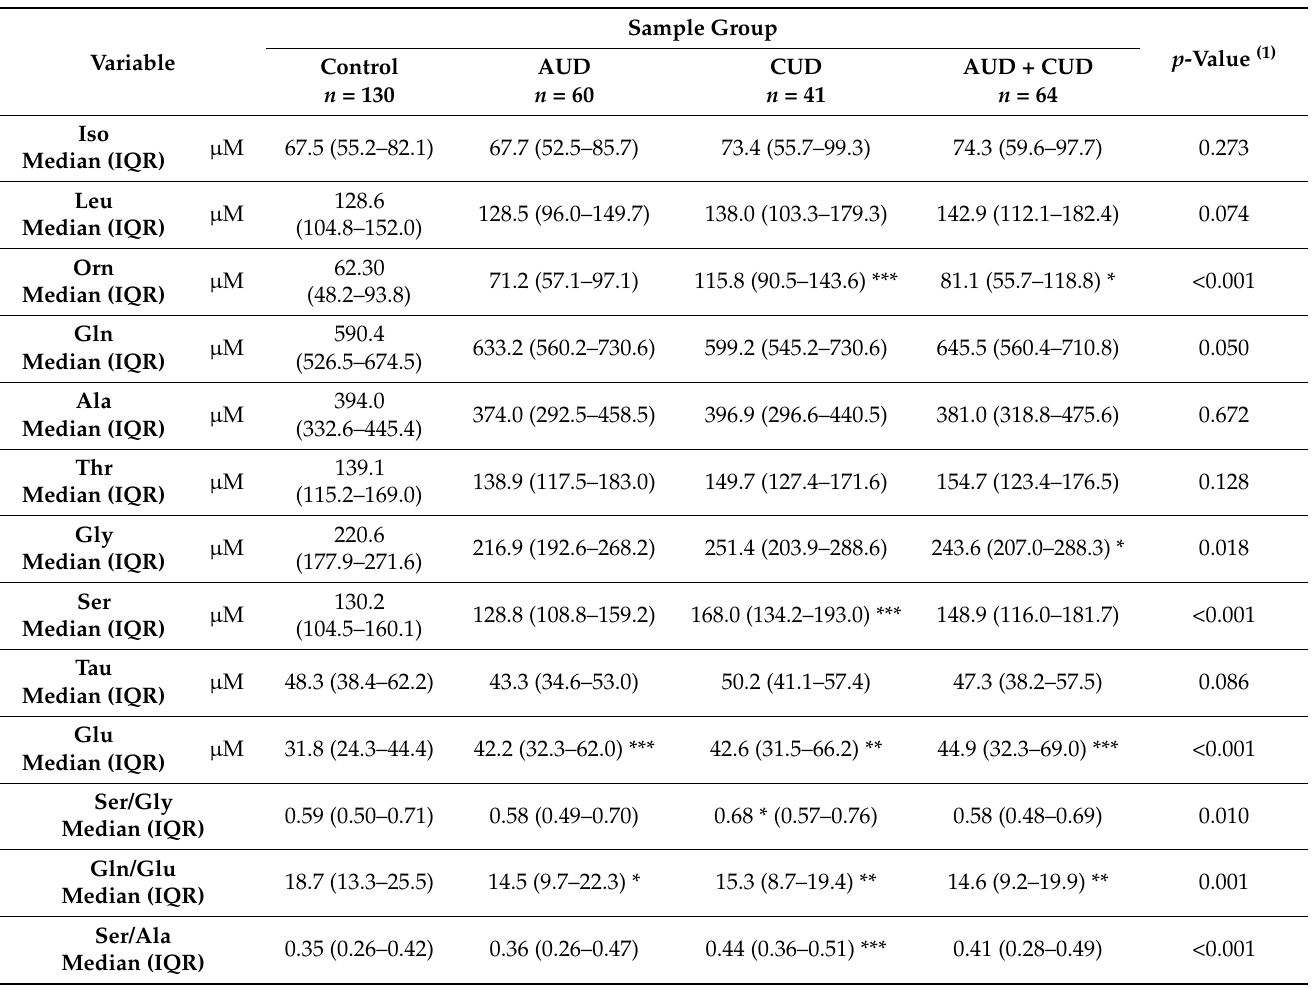
Table 2. Plasma amino acid